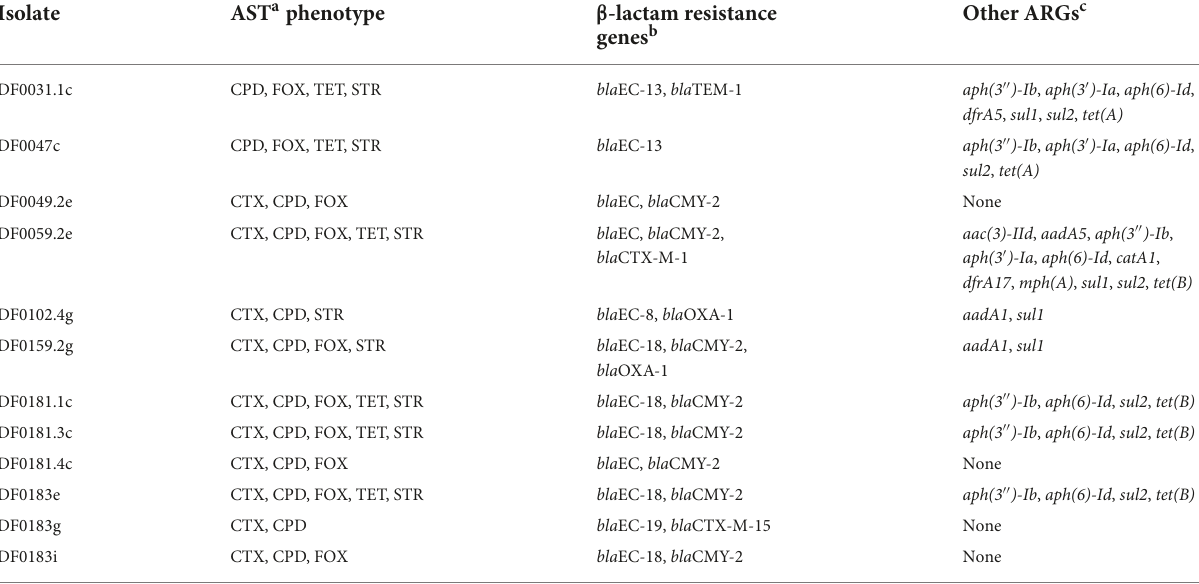
TABLE 4 Resistance profiles of ESBL- and AmpC-producing E. coli ( n = 12). Isolate